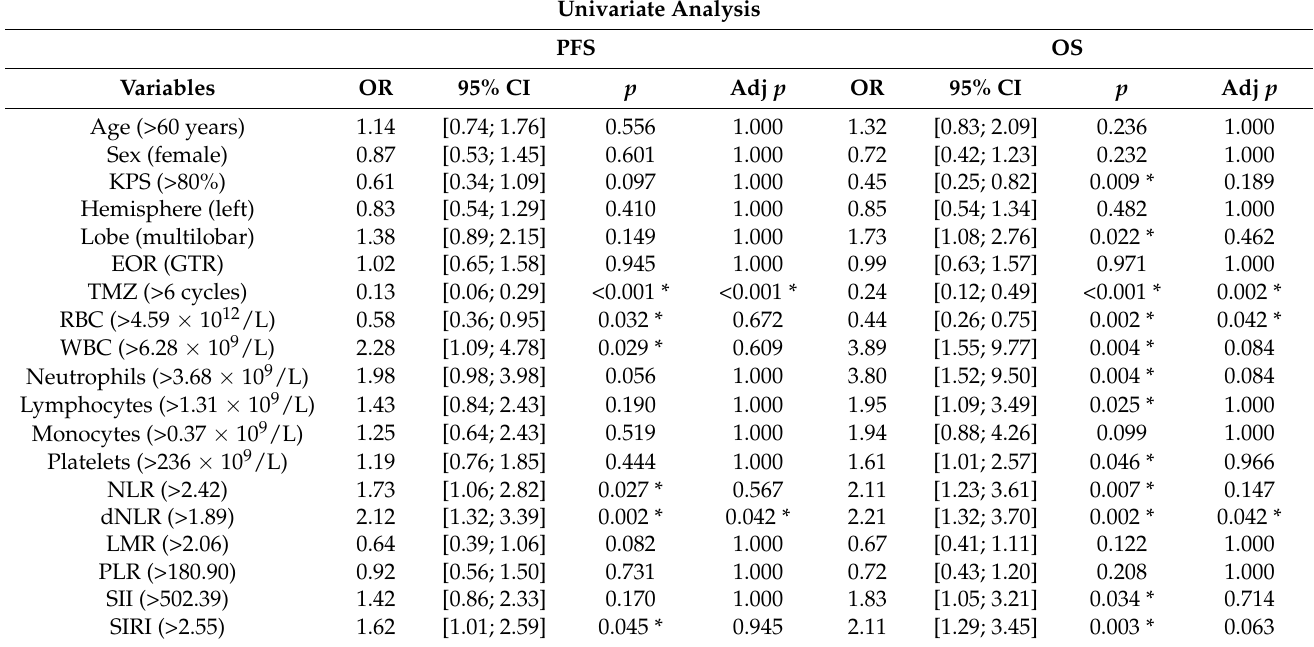
Table 2. Univariate Cox regression analysis of factors associated with PFS and OS. Abbreviations: Adj p , Bonferroni adjusted p -value; CI, confidence interval; dNLR, derived neutrophil-to-lymphocyte ratio; EOR, extent of resection; GTR, gross total resection (100%); KPS, Karnofsky performance score; LMR, lymphocyte-to-monocyte ratio; NLR, neutrophil-to-lymphocyte ratio; OR, odds ratio; PFS, progression-free survival; PLR, platelet-to-lymphocyte ratio; RBC, red blood cells; SII, systemic immune-inflammation index; SIRI, systemic inflammation response index; TMZ, temozolomide; WBC, white blood cells. * p < 0.05.